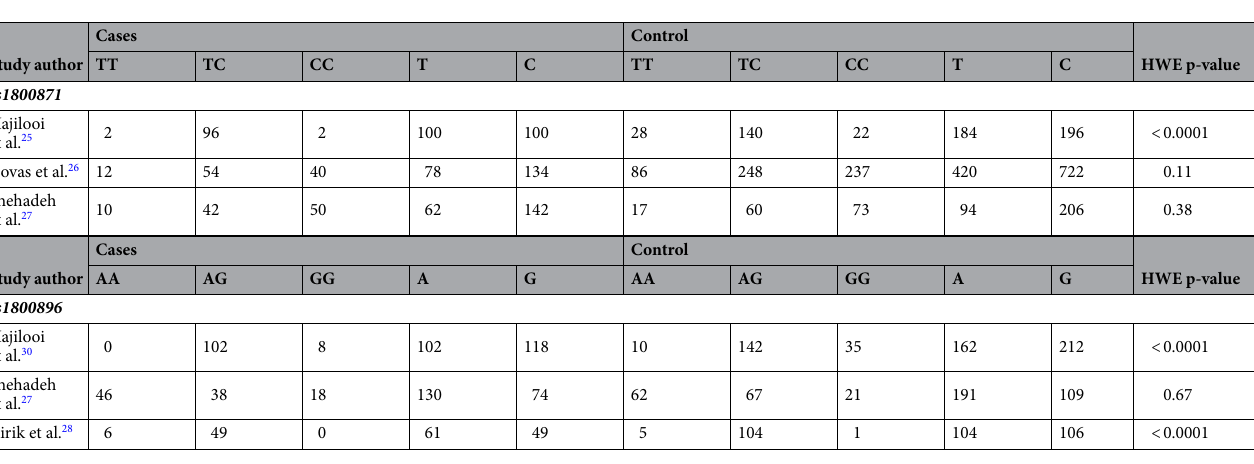
Table 2. Distribution of genotype and allele from studies included in the meta-analysis among leishmaniasis patients and controls.